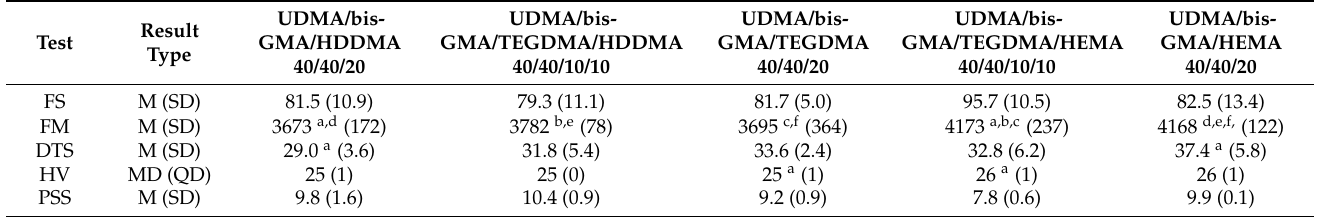
Table 3. The results of flexural strength (FS), flexural modulus (FM), diametral tensile strength (DTS), hardness (HV) and polymerization shrinkage stress (PSS) for composite materials. Values are given as mean with standard deviation (SD) or median with quartile deviation (QT), based on distribution and homogeneity of variance. The results with the same assigned letter show a statistical difference at the level of p ≤ 0.05. The results without the assigned letter do not show a statistical